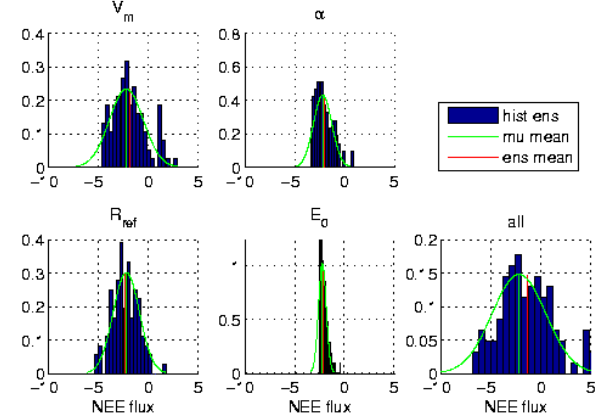
Fig. 3. The distribution of calculated NEE from 5PM given a Gaus- sian distribution of values for four different parameters in the model. The figure shows the linear translation of for instance V c max and R 10 to a Gaussian shaped NEE distribution, and the non-linear re- sponse of α and E 0